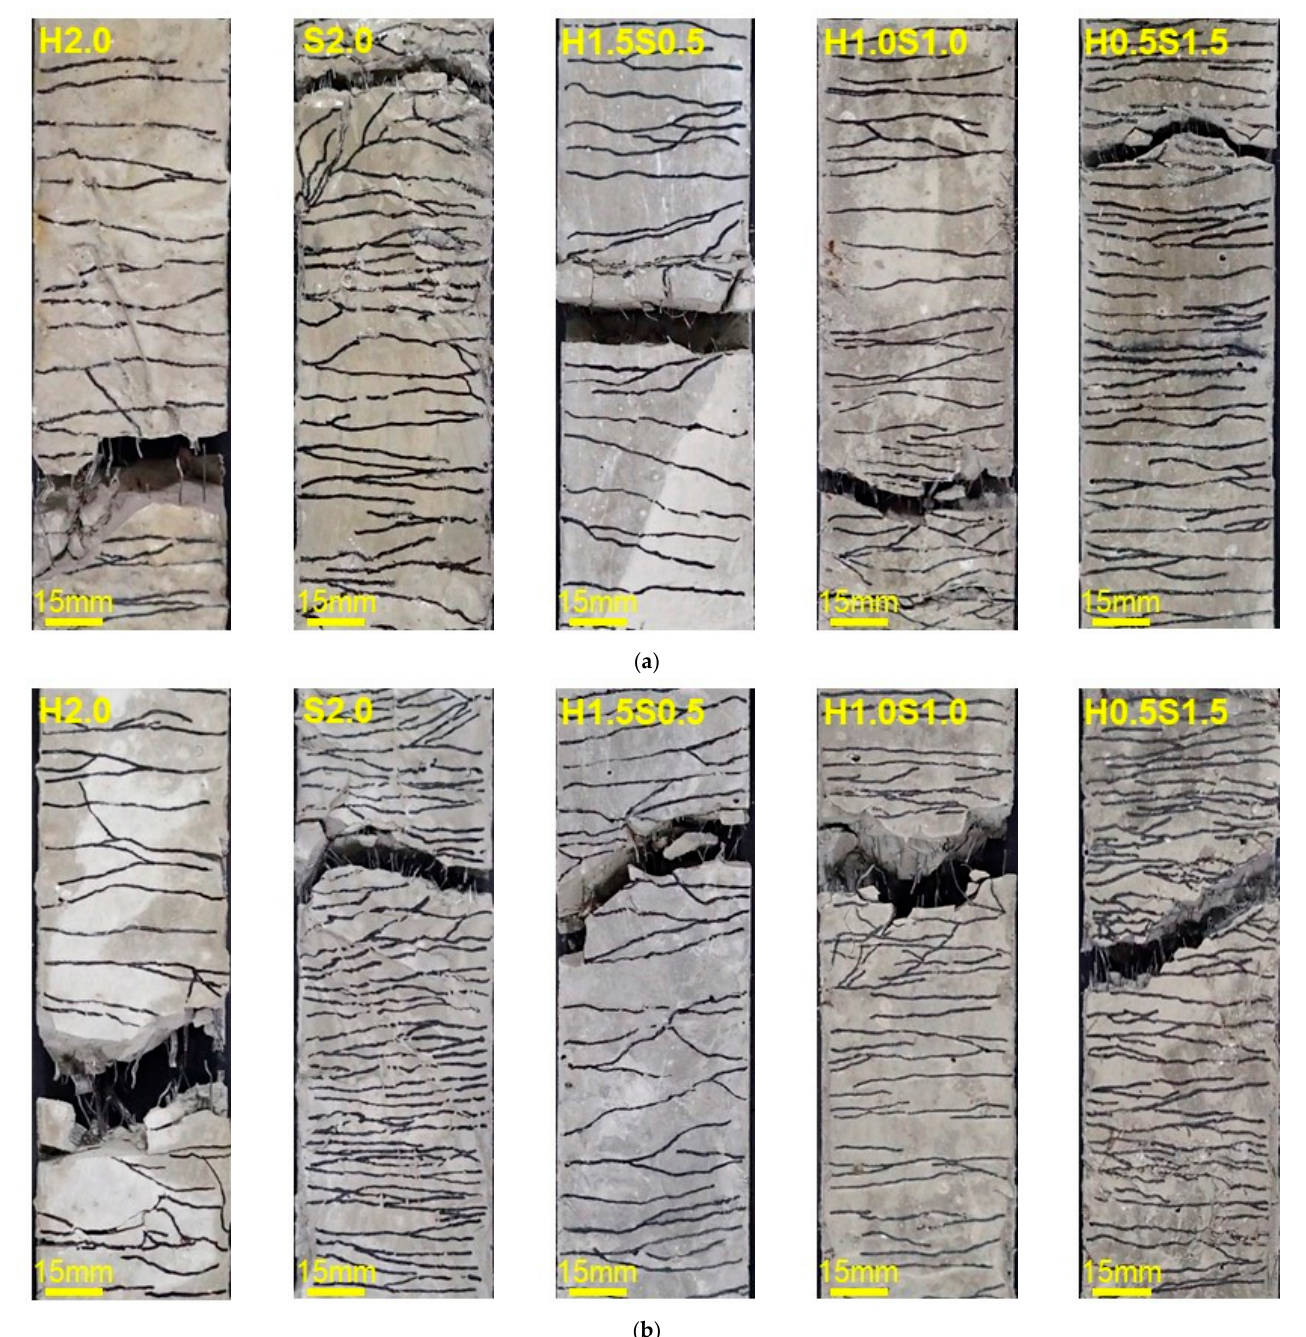
Figure 8. Multiple cracking pattern of HPFRCC within gauge length: ( a ) static rate; ( b ) high rate. Table 5. Tensile properties of HP-MFRCC.